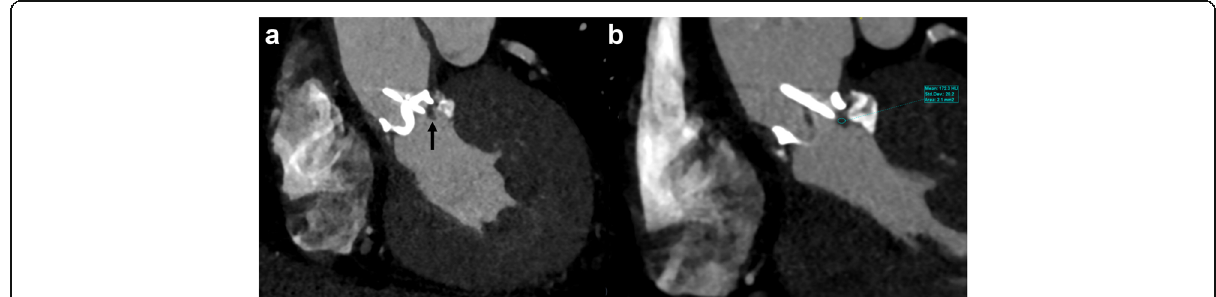
Fig. 13 A 64-year-old male status post aortic valve replacement using Hall tilting disc valve (Medtronic, Inc., Minneapolis, Minn) and shortness of breath with increasing prosthetic aortic valve gradient on echocardiogram. Coronal oblique CTA reconstructed images reveal ovoid hypoattenuating lesion (Hounsfield unit, 172) at the inferior surface of the valve ring causing restricted valve opening, consistent with pannus formation